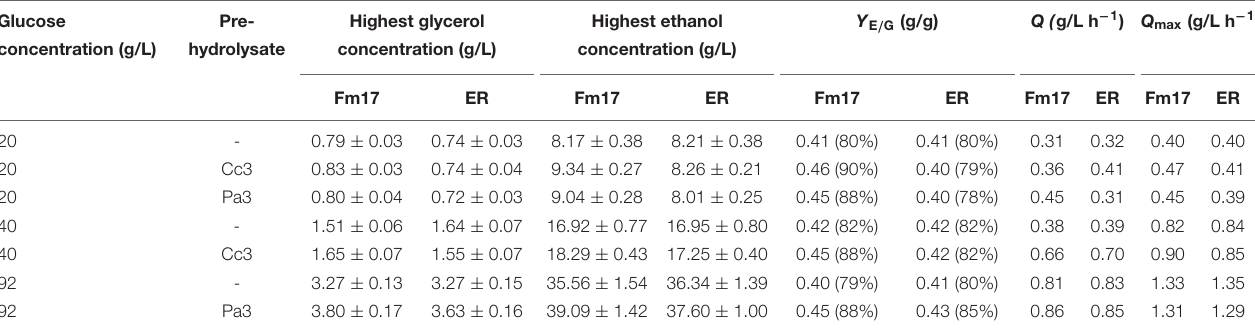
TABLE 6 | Fermentative performances at 30 ◦ C of Saccharomyces cerevisiae strain Fm17 and the benchmark S. cerevisiae Ethanol Red (ER) when incubated in the presence of pre-hydrolysate Cc3 and Pa3 supplemented with 20, 40, or 92 g/L glucose. Glucose Pre- Highest glycerol Highest ethanol